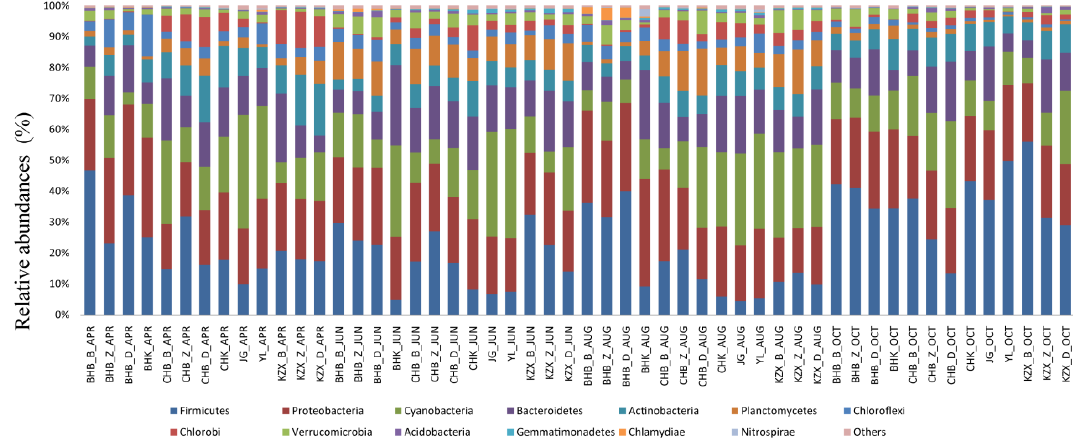
Figure 4. Phylum-level changes of the bacterial sequences in different month–site assemblages.